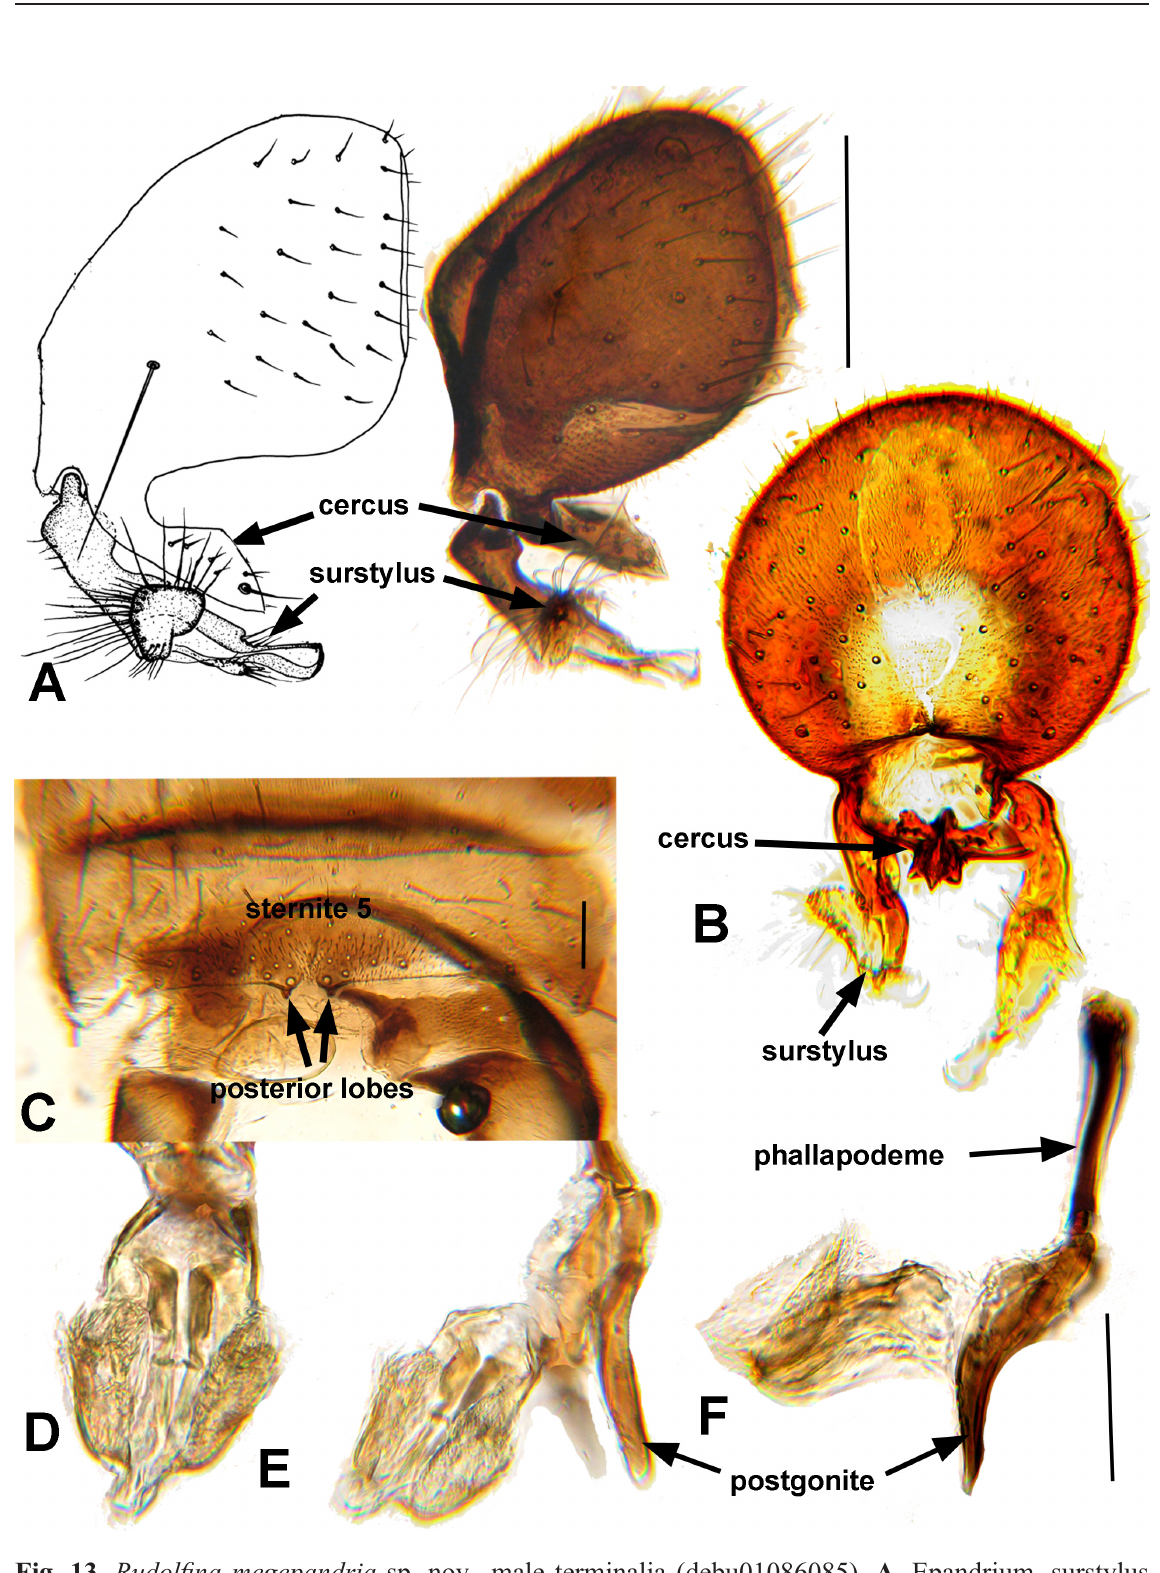
Fig. 13. Rudolfina megepandria sp. nov., male terminalia (debu01086085). A . Epandrium, surstylus and cercus, lateral view. B . Same as preceding, caudal view. C . Sternites 4–7, ventral view. D . Phallus and postgonite, dorsal view. E . Phallus, postgonite and phallapodeme, dorsolateral view. F . Same as preceding, lateral view. Scale bars: A–B = 0.20 mm; C = 0.05 mm; D–F = 0.05